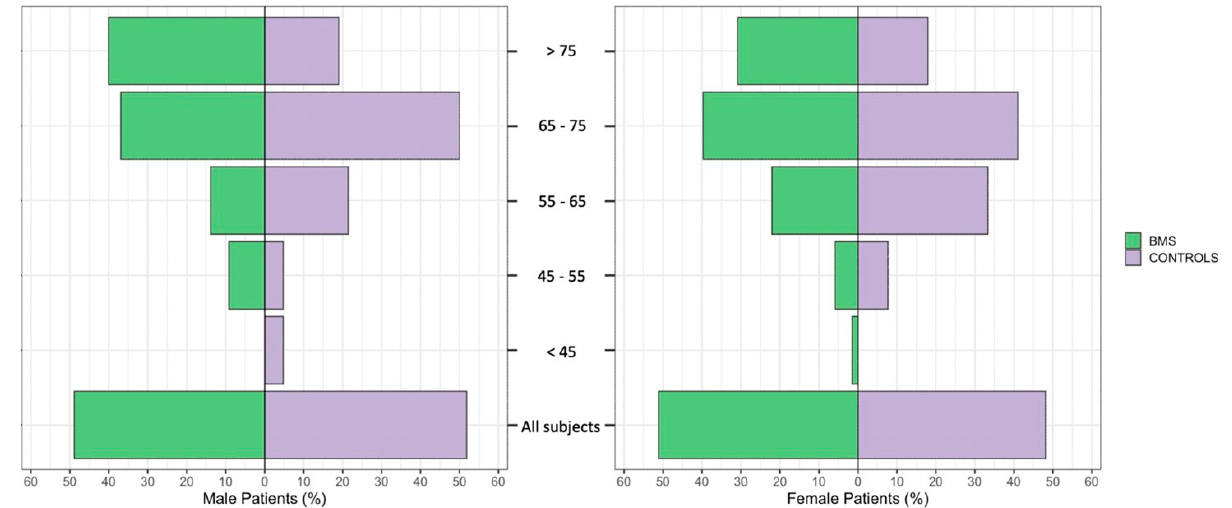
Figure 2. Frequency distribution of HTN by age ranges and gender among 133 BMS patients and 81 controls.